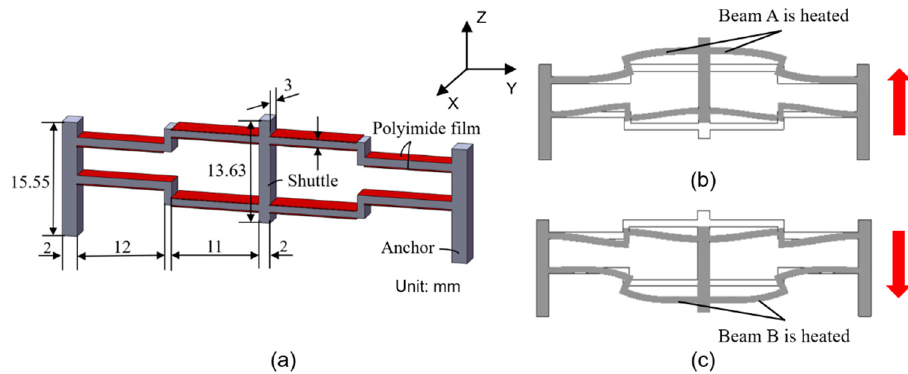
Figure 2. Structure of Z-shaped electrothermal actuator. ( a ) structure and dimensions of the bi-directional Z-shaped actuator; ( b ) When the beam A of the Z-shaped actuator are heated; ( c ) When the beam B of the Z-shaped actuator are heated.